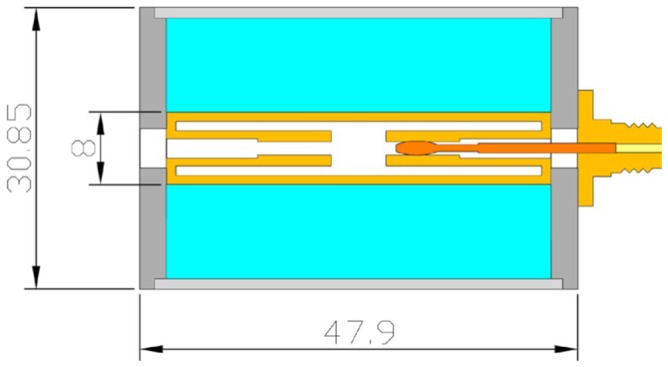
Drawing of the standard transmission cell.This cell was designed for ease of operation in particular for rapid sample change. Its short length, in combination with cables with right-angle male SMA connectors, allows orientation of the TEM axis parallel to the B-axis of a wide-gap magnet. The light-blue area is the sample compartment.